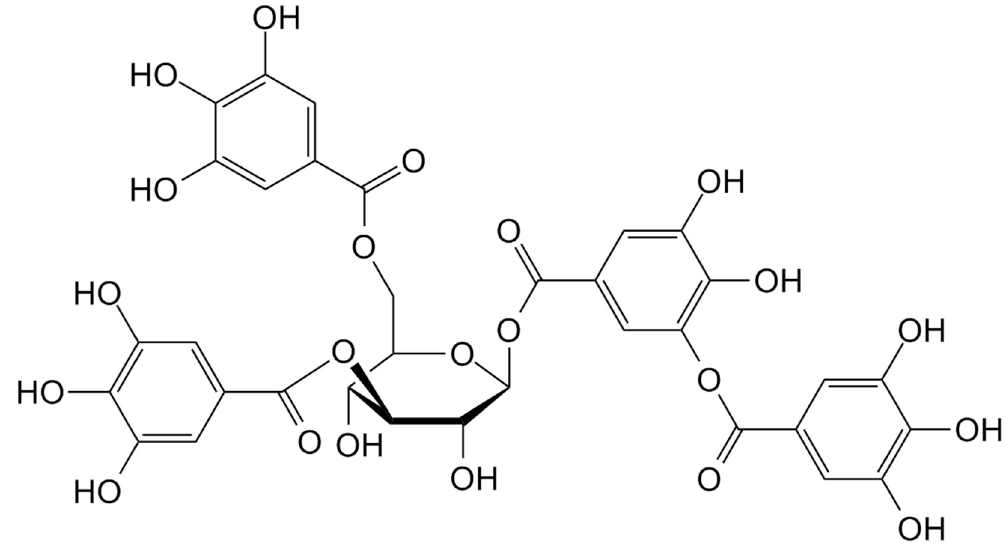
Figure 10. Structure of tannin.